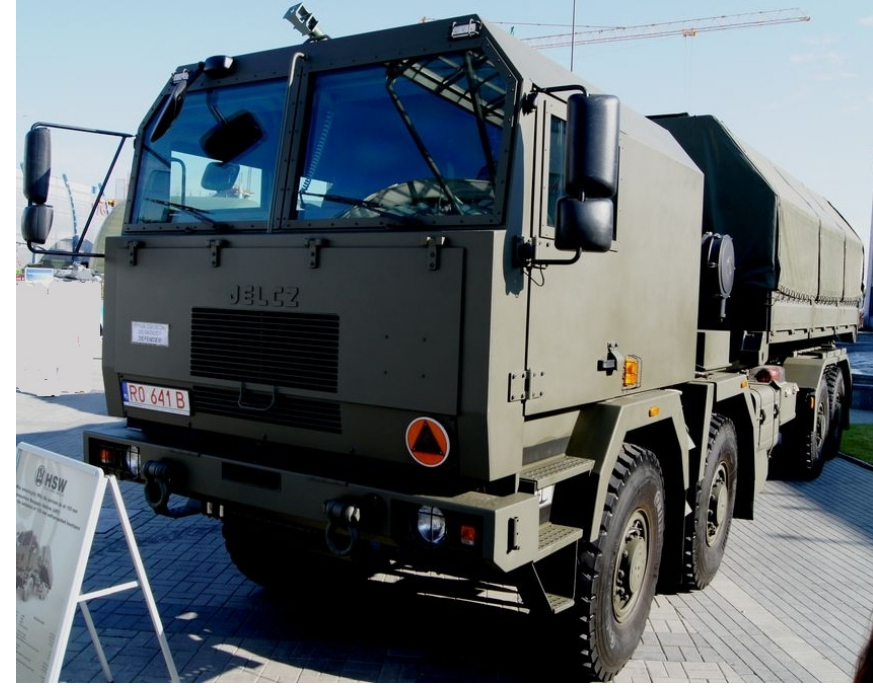
Figure 6. General view of the tested vehicle [33].